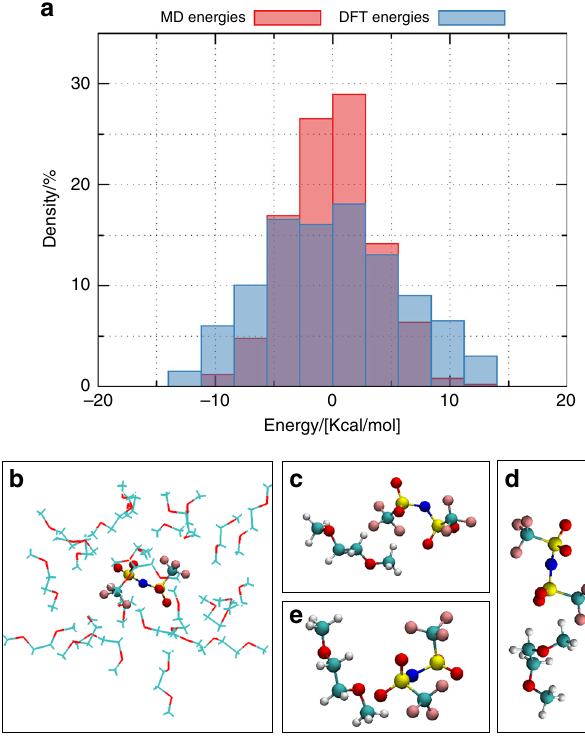
Fig. 5 Figure a represents for 200 con fi gurations of anion-solvent pairs from MD snapshots for the (TFSI − , PC) pair, the distribution in energy computed from MD and the distribution of energy computed from DFT (M06-HF). Both these distributions are plotted relative to their average. b shows a solvated anion for an MD snapshot in the case of the (TFSI − , DME) pair. c – e show examples of con fi gurations of solvent-anion pair from MD snapshots for the (TFSI − , DME)